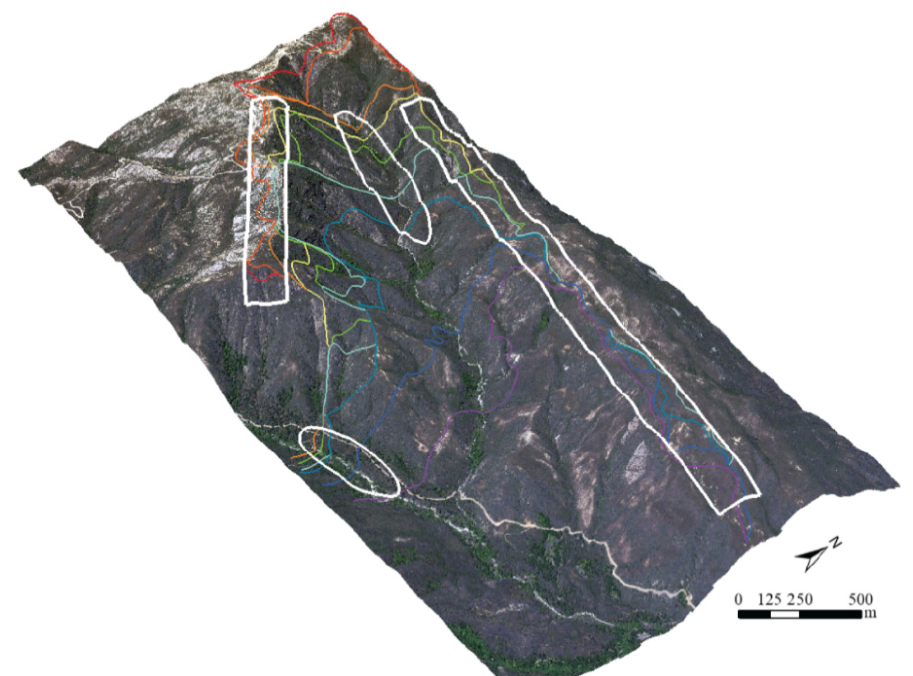
Figure 7. Zones of impeded fire spread at Thomas sequence 4. White rectangle polygons showing fire spread along ridgetops and elliptical polygons highlighting spread along valley bottoms. Progression of color spectrum illustrates movement of fire fronts over time.